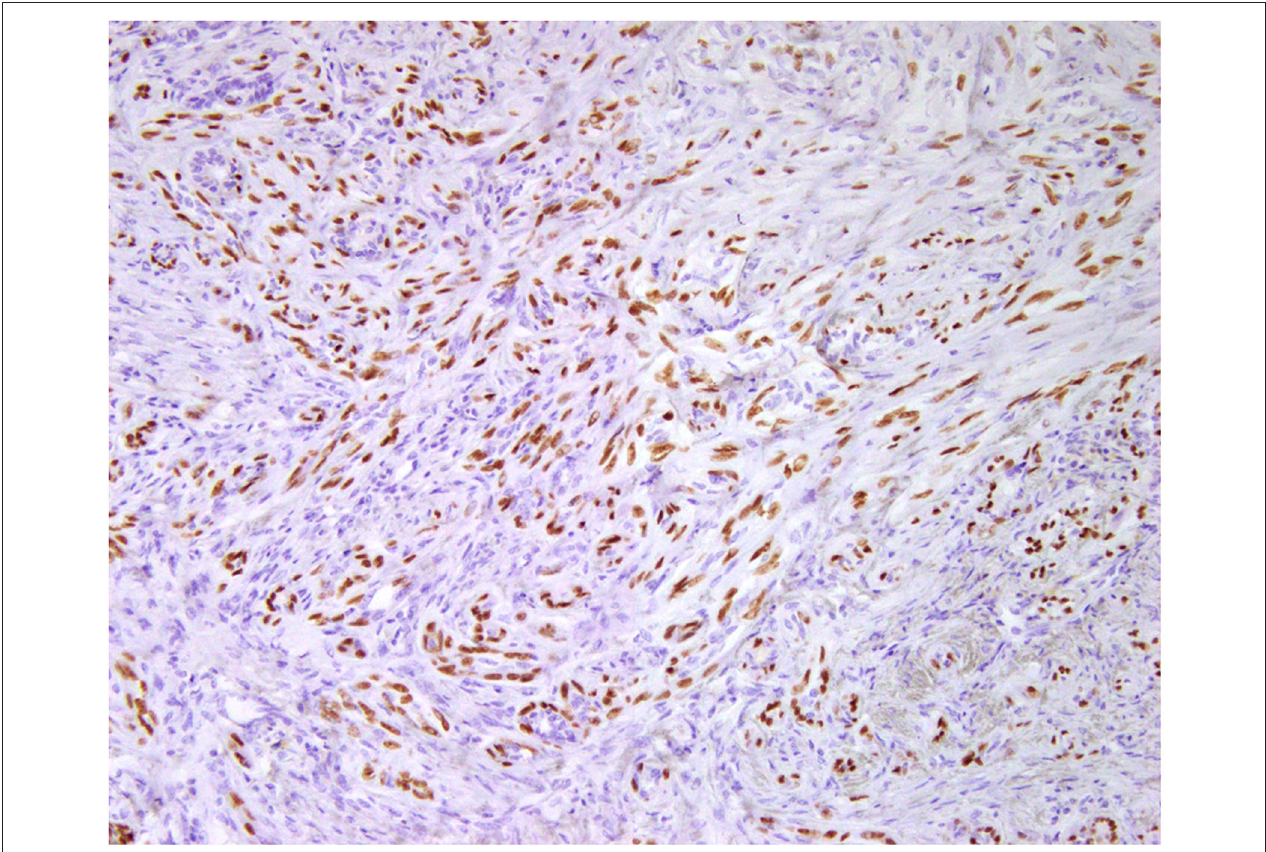
FIGURE 5 | Carcinoma and malignant myoepithelioma, mammary gland, dog. Immunohistochemical nuclear staining of p63 . Interstitial proliferated myoepithelial cells are positive.